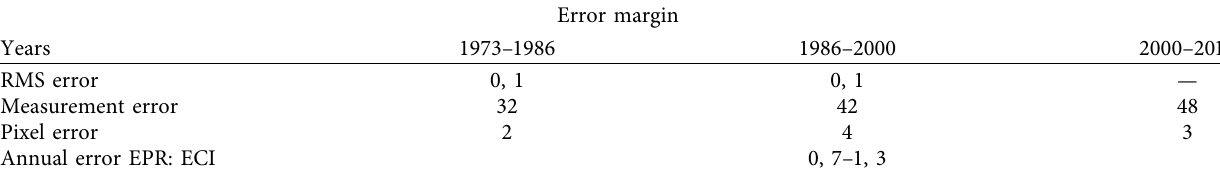
Table 3: Precision on shoreline definition.